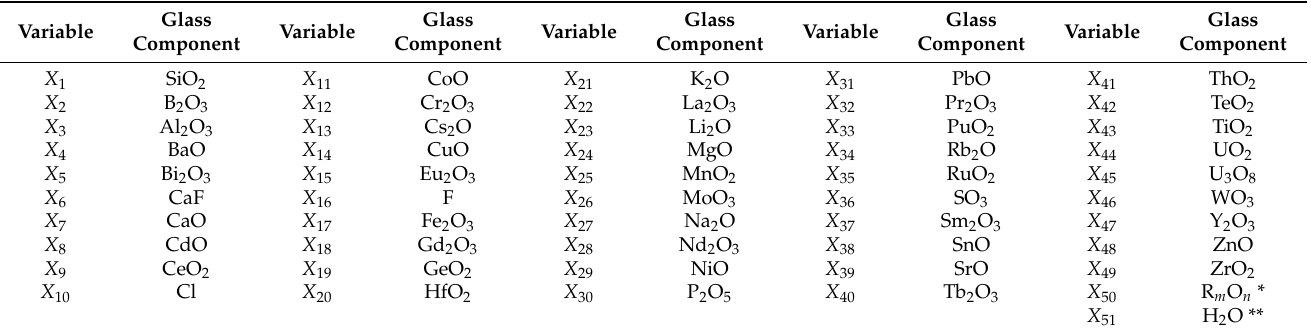
Table 1. Definition of each variable (or substance) X i , i from 1 to n = 51, related to the composition of every glass analyzed in this